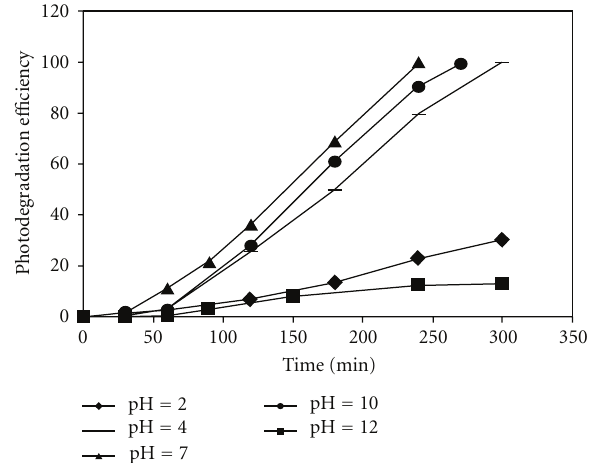
Figure 4: E ff ect of nano-TiO 2 concentration on TEP degredation (TEP = 30mg/li, pH = 7). Figure 5: The e ff ect of pH on reaction rate (TEP = 30 mg/li and nano-TiO 2 = 400